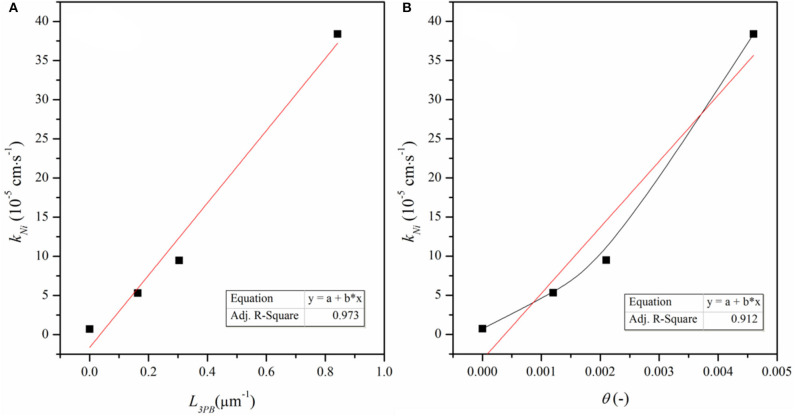
kNi as a function of (A) density of 3PB (L3PB) and (B) surface coverage of Ni particles, (θ).